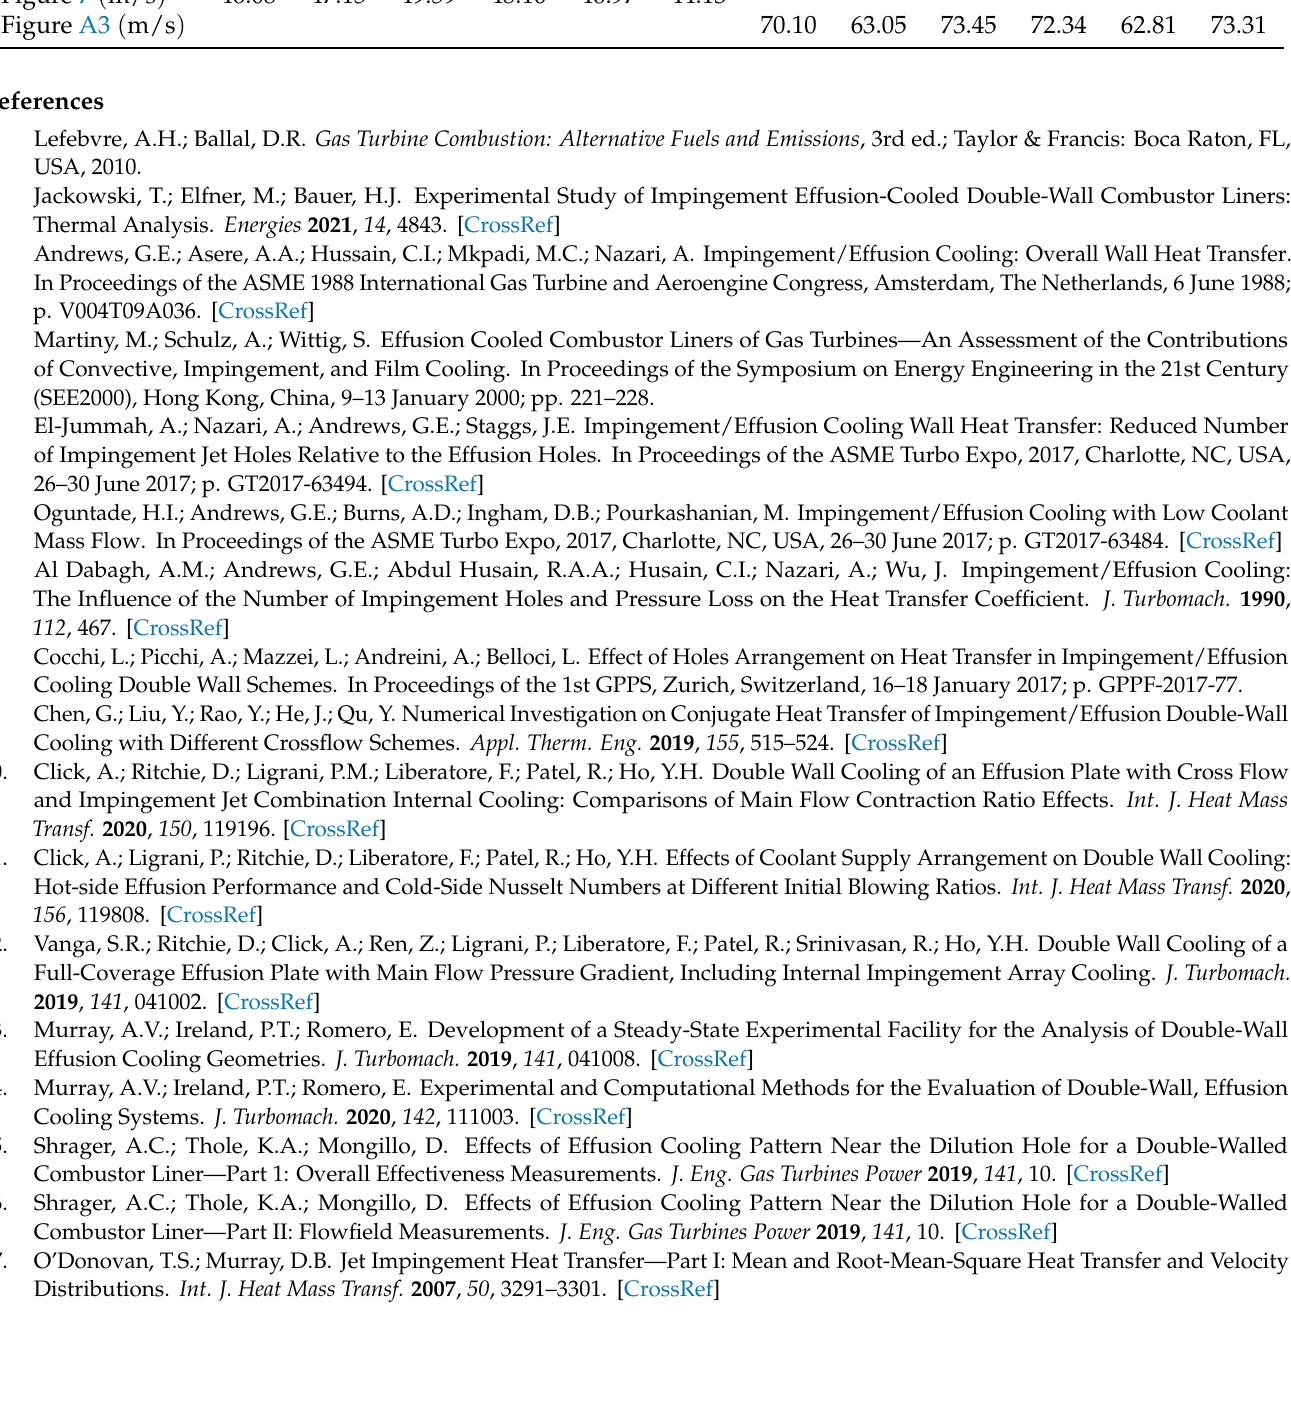
Figure A2 ( m/s ) Figure A3 ( m/s